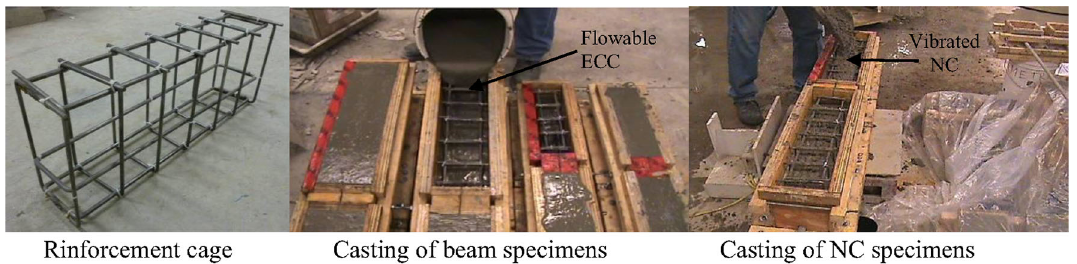
Fig. 4 Reinforcement cage for Type B specimen and casting of A and B